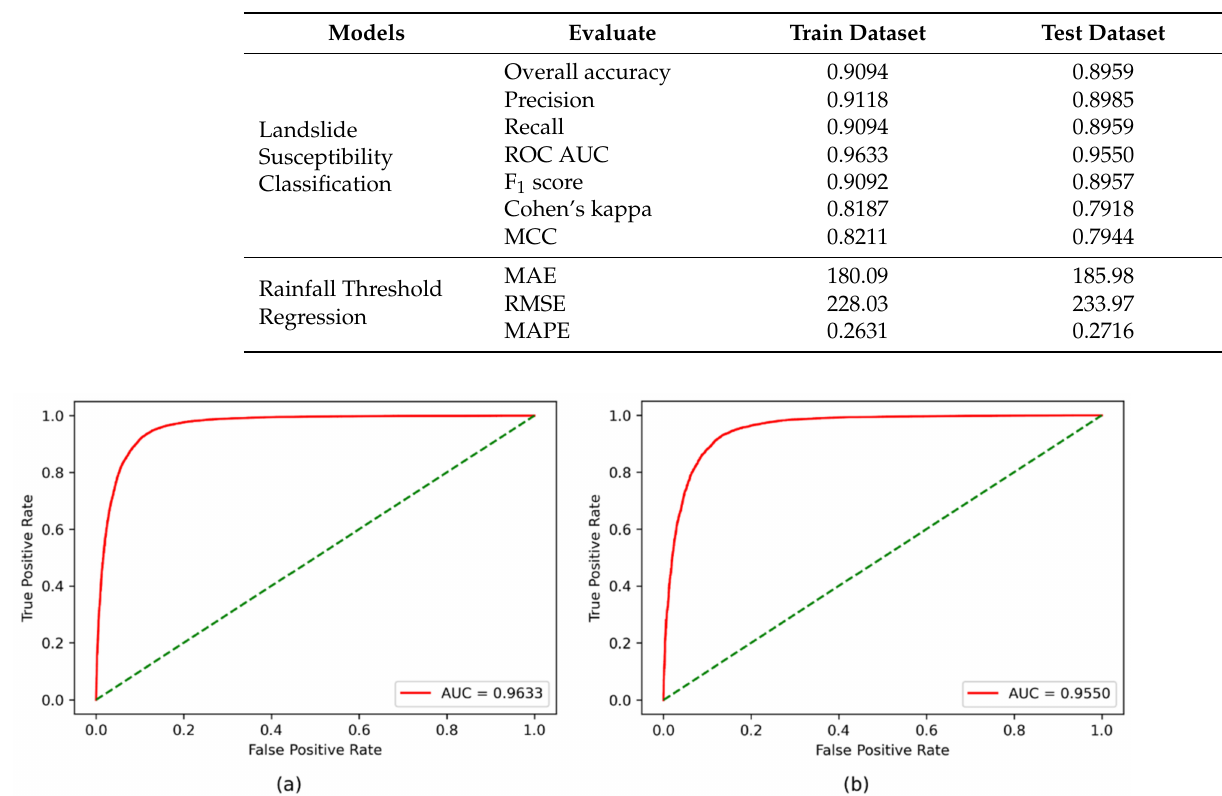
Figure 8. The accuracy and loss trend of training and validation dataset. ( a ) Landslide susceptibility classification model; ( b ) rainfall threshold regression model. Table 5. The evaluated result for models.